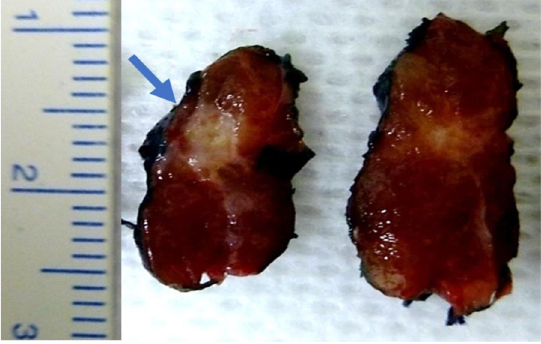
Fig. 5. Gross appearance of an incidental papillary carcinoma with a major axis of 0.5 cm (blue arrow).